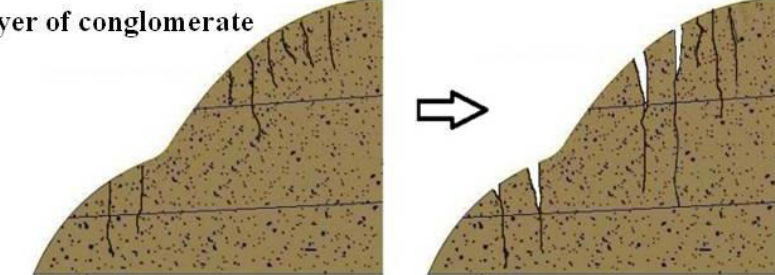
Figure 20. Schematic description of the tension crack destruction in red-bed slopes in South China.